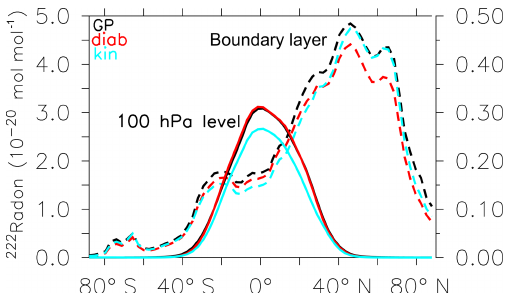
Figure 2. Zonal mean 222 Rn mixing ratio in the boundary layer (av- eraged over the lowest three model layers; dashed line, left vertical axis) and at 100hPa (solid line, right vertical axis). GP denotes the grid-point simulation with EMAC (black line), LG(diab) the simu- lation with EMAC–ATTILA using the diabatic vertical velocity (red line), and LG(kin) the EMAC–ATTILA simulation with kinematic vertical velocity (light blue line).